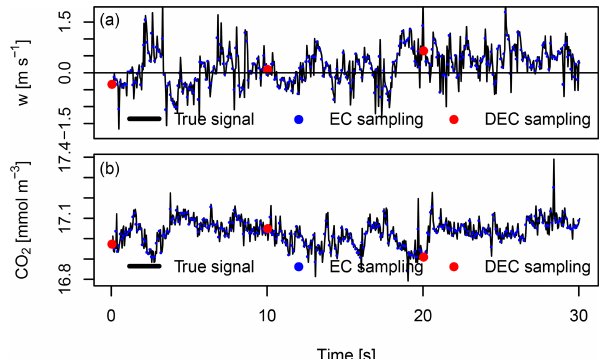
Figure 3. Eddy covariance and disjunct eddy covariance sampling scheme. Vertical wind, w (a) , scalar density, CO 2 (b) . Black solid lines indicate the continuous true atmospheric signal. Sampling res- olution of EC and DEC are 10Hz and 10s, respectively. Note that active sampling time for DEC is only 1% of the sampling time for